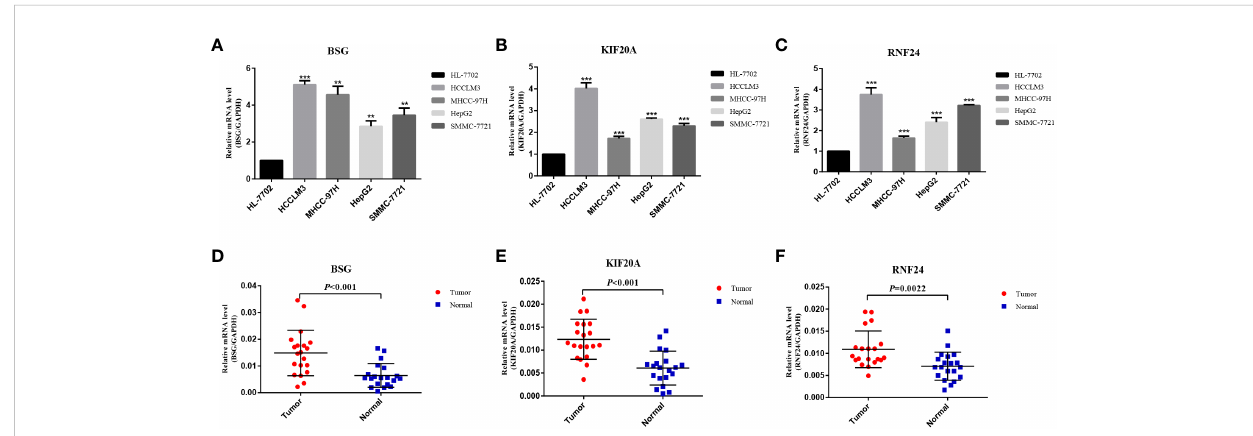
FIGURE 7 Validation of differential expression of 3 signature genes in cells and tissues by q-PCR. (A – C) Differential mRNA expression of 3 signature genes in HL-7702, HCCLM3, MHCC-97H, HepG2 and SMMC-7721 cells. (D – F) Differential mRNA expression of 3 signature genes in HCC tissue and paraneoplastic tissue (20 pairs). **<0.01, ***